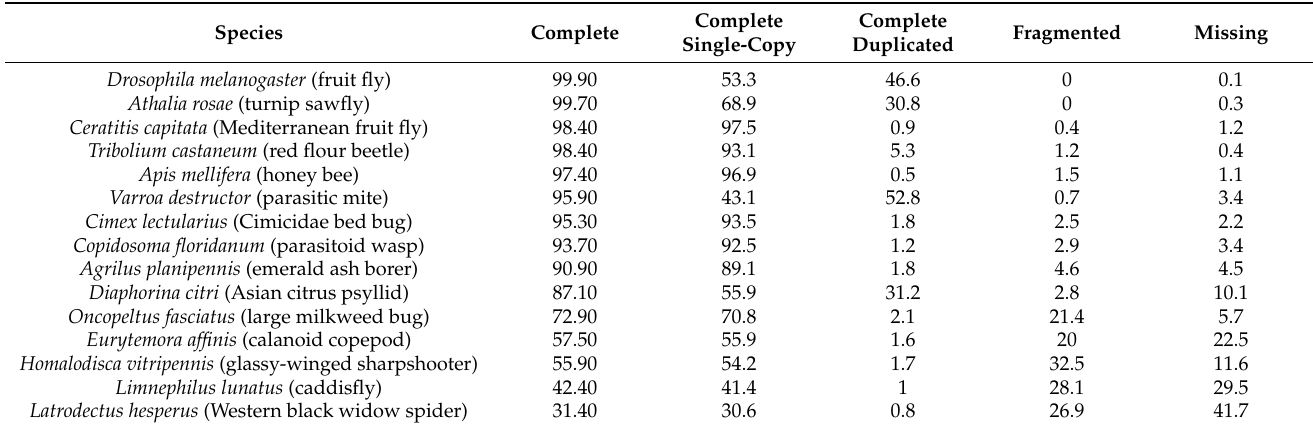
Table 4. Arthropod genomes selected for this study and their BUSCO completeness statistics. The test species are sorted by the BUSCO completeness score. BUSCO version 5.1.2 was used with the protein option and arthropoda_odb10.2019-11- 20 database with 1013